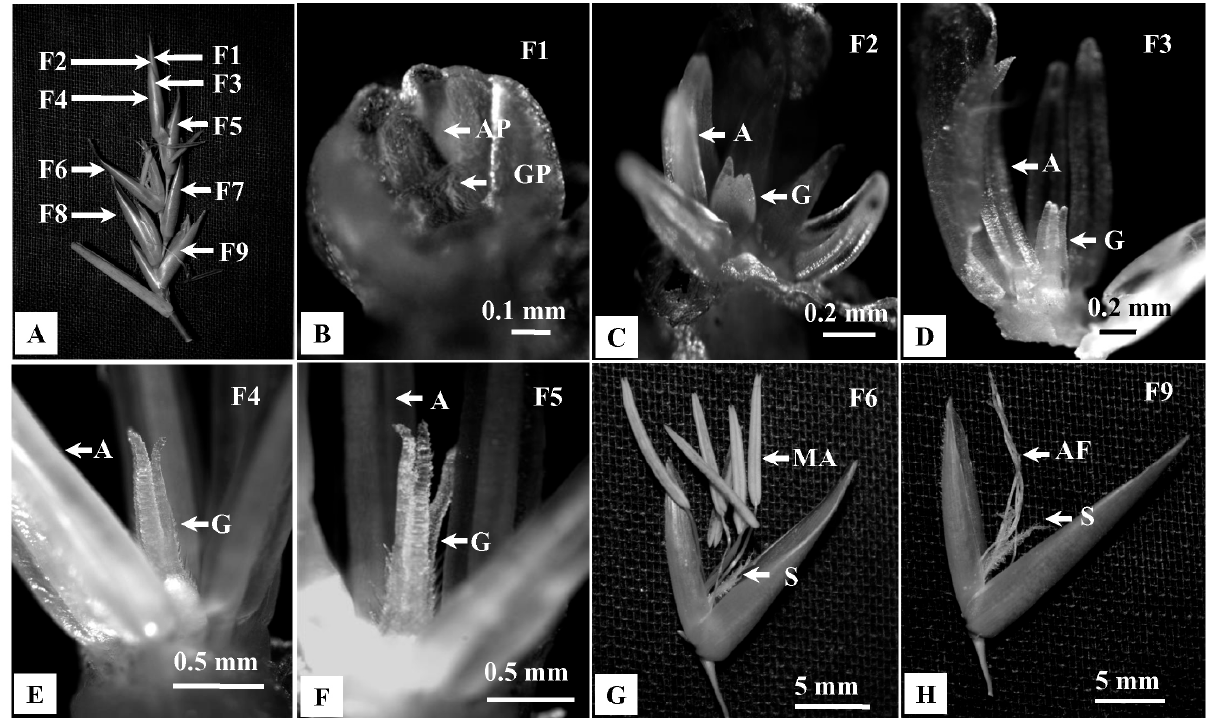
Figure 5. Developmental progression of androecium and gynoecium in florets of B. tulda . Floret numbers are marked from apex to base in order of maturity (F1—youngest, F7—oldest floret). ( A ) Arrangement of florets in a spikelet. ( B – E ) Developmental stages of androecium and gynoecium primordia. ( F ) Unopened flower with matured anthers and immature gynoecium. ( G ) Open floret with matured anthers and immature stigma. ( H ) Floret with anther filaments and developed stigma. Abbreviations used: AP—Androecium primordia, GP—Gynoecium primordia, A—Androecium, G—Gynoecium, MA—Mature anther, AF—Anther filament,